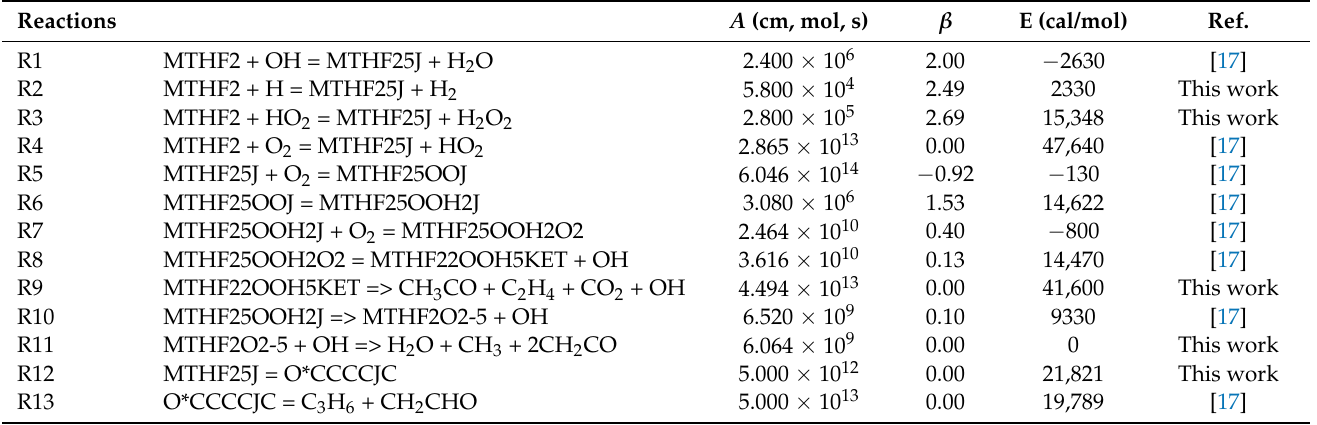
Table 1. Reactions in MTHF2 sub-mechanism.